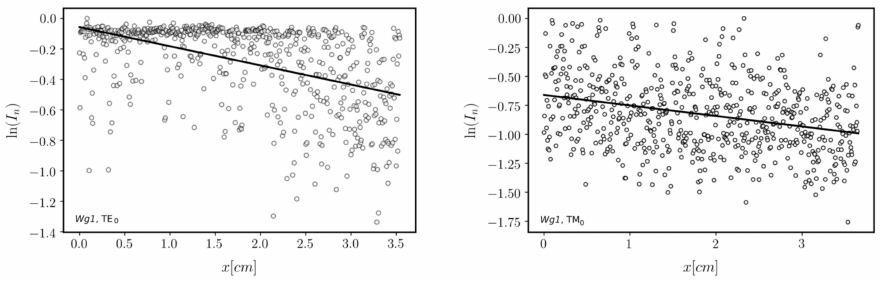
Figure 9. The linearized distribution of normalized light intensity for linear scans selected from light streaks is presented in Figure 7